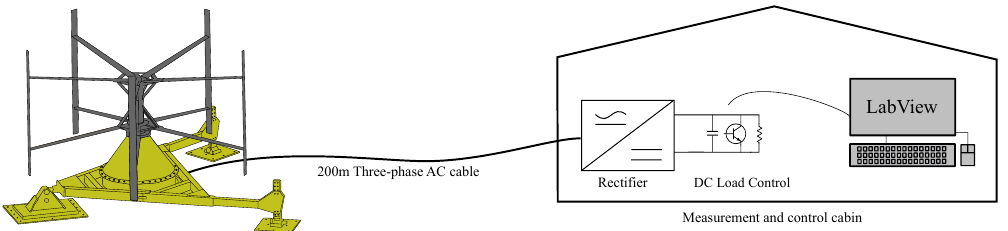
Figure 2. The turbine and generator are connected to the on-shore measurement and control cabin where the rectifier and DC load control is